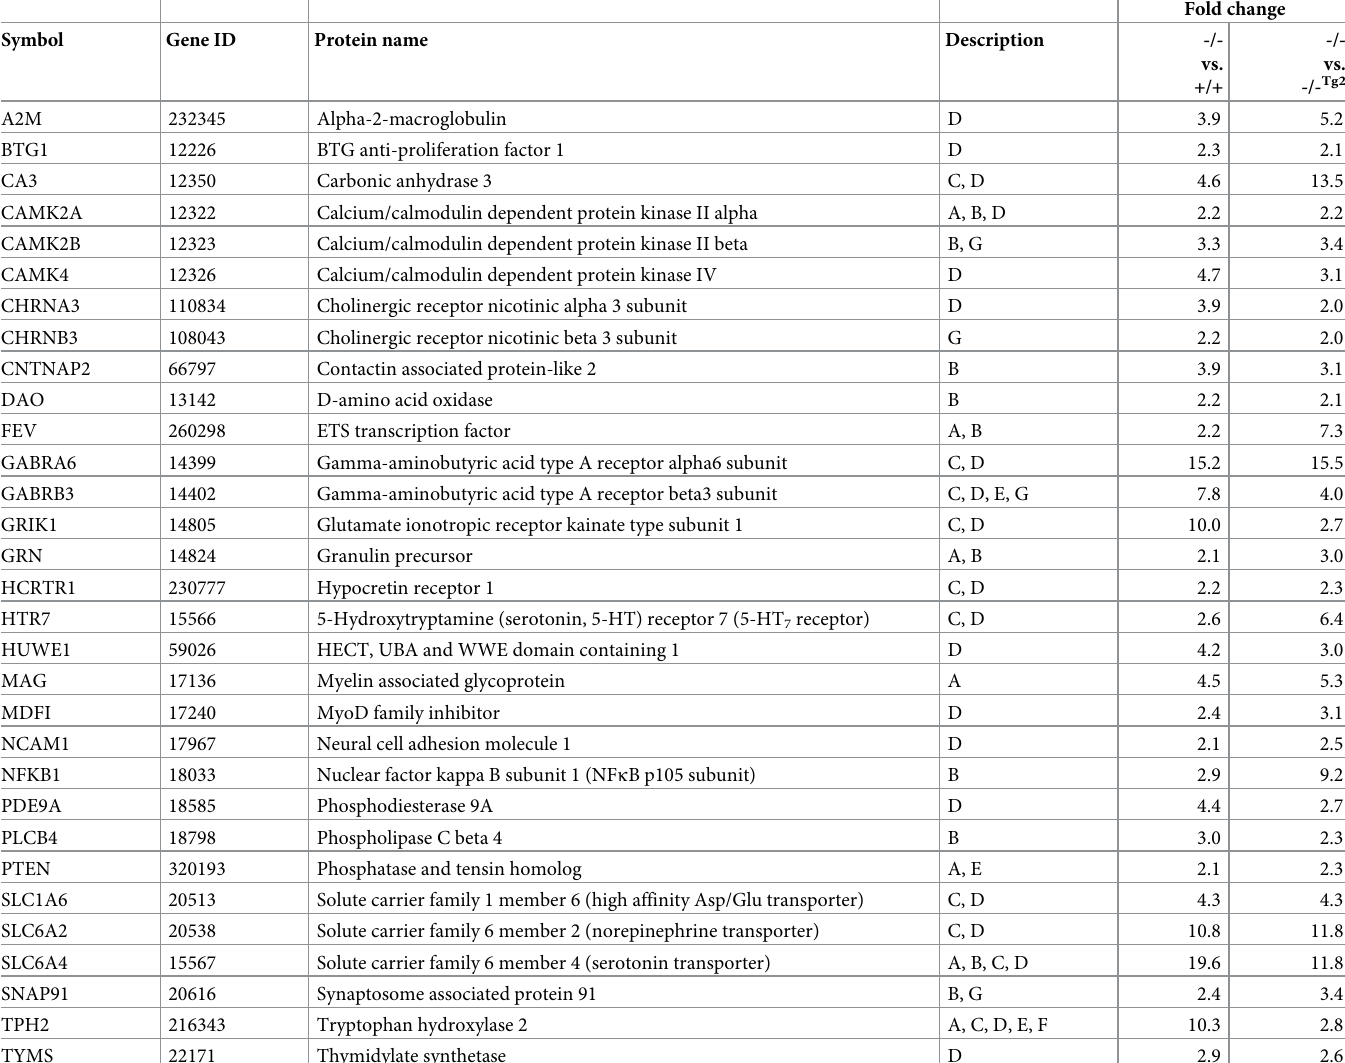
Table 2. Upregulated genes in TDAG51 -/- brain tissues after